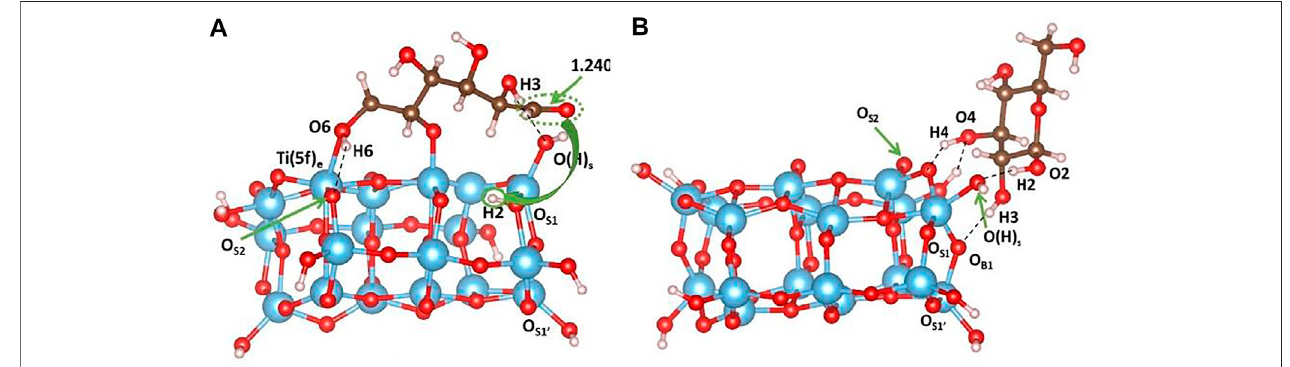
FIGURE 6 | Minimum-energy structures obtained at the B3LYP level of theory for D -glucose adsorption on the cluster containing (A) surface and (B) subsurface oxygen vacancy. In panel (A) , the yellow arrow highlights the H2 transfer from O2 to O S1 . Color code: O, red; H, white; Ti, blue; C, brown.